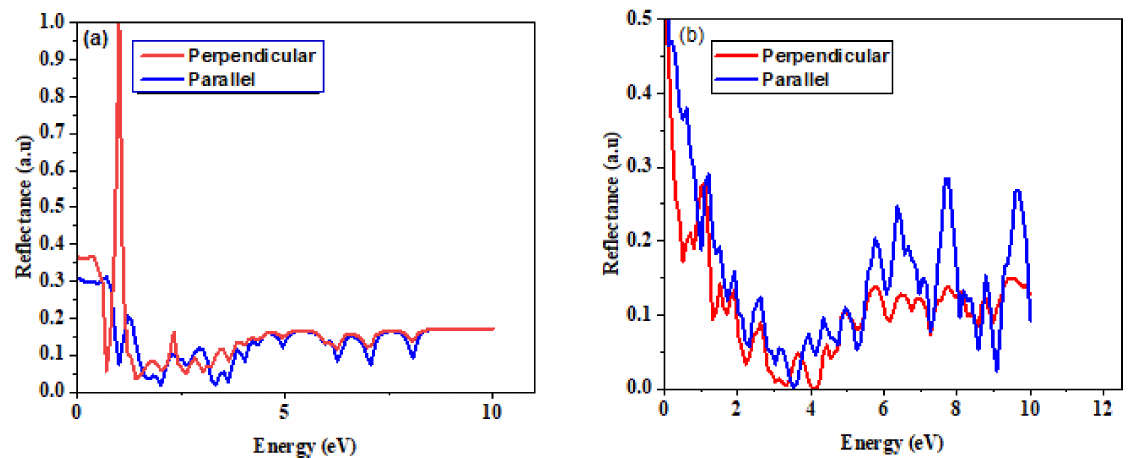
Figure 5. Optical reflection of ( a ) armchair (5, 5) SWBNNT and ( b ) armchair (5, 5) SWCNT